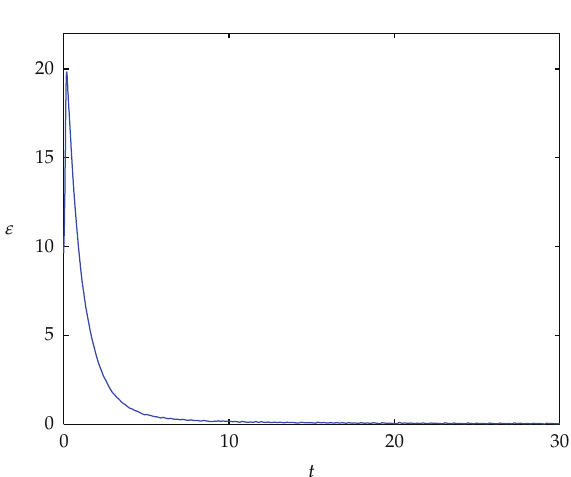
Figure 4: The HPS result between the drive system (cid:4) 3.6 (cid:5) and its response system (cid:4) 3.7 (cid:5) for q (cid:7) 0 . 95.